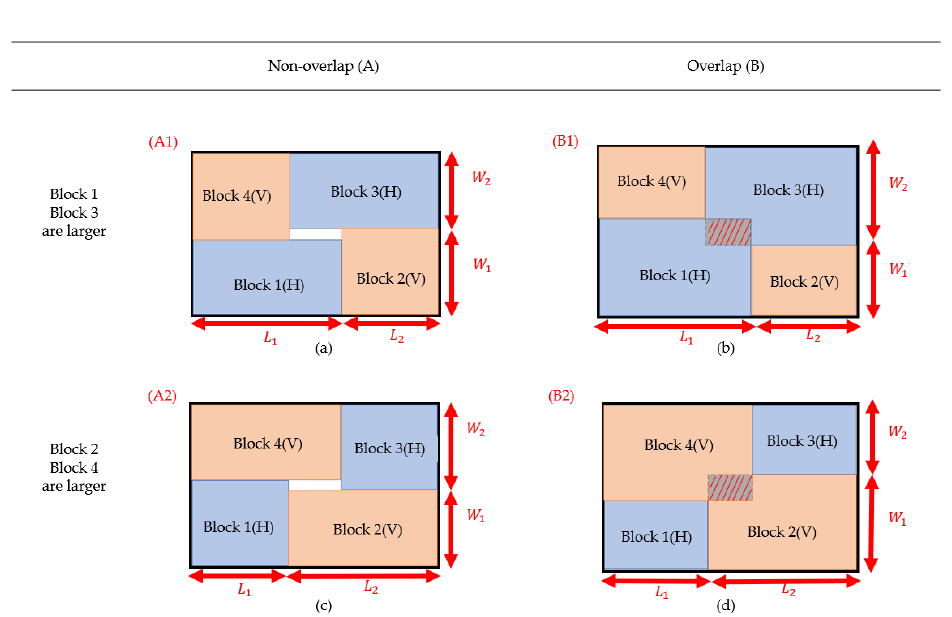
Figure 4. Symmetrical arrangement results. ( a ) Blocks 1 and 3 are bigger than blocks 2 and 4 re- spectively, and no overlap occurs. ( b ) Blocks 1 and 3 are bigger than blocks 2 and 4 respectively, and overlap occurs. ( c ) Blocks 2 and 4 are bigger than blocks 1 and 3 respectively, and no overlap occurs. ( d ) Blocks 2 and 4 are bigger than blocks 1 and 3 and overlap